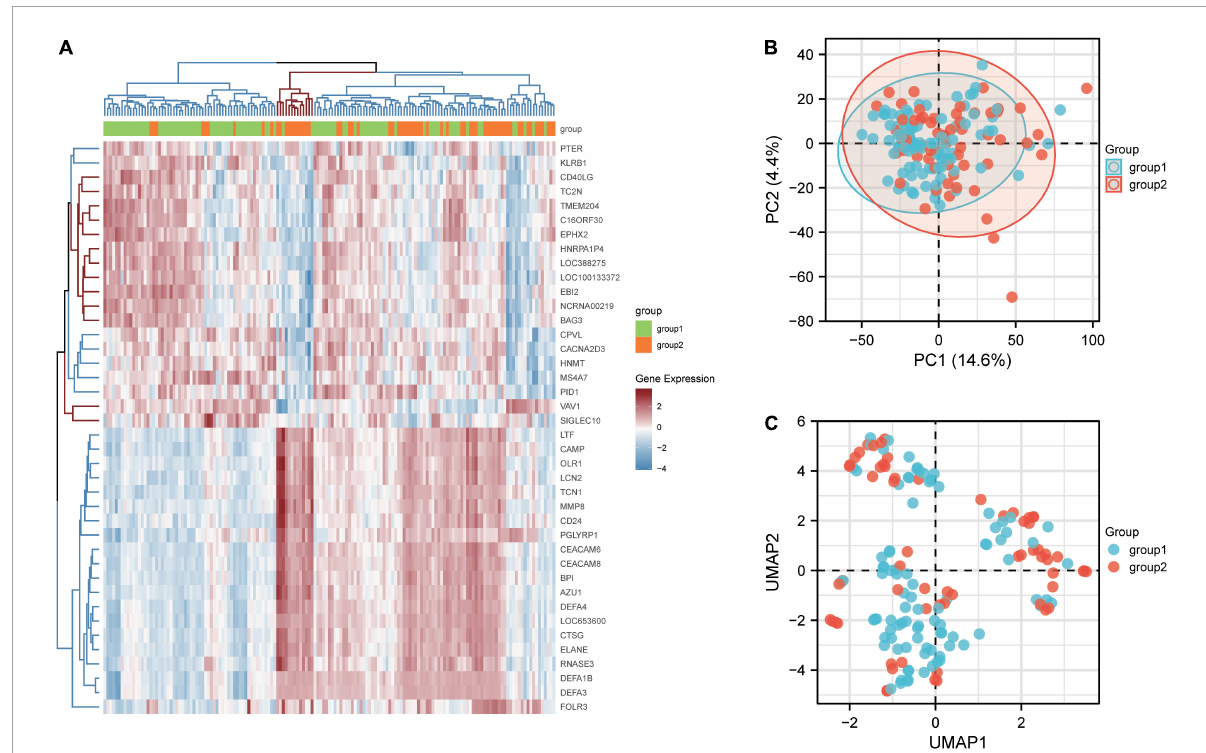
FIGURE2 Identification of DEGs between patients with and without renal involvement. (A) Heatmap of GSE65391, (B) principal component analysis (PCA) plot generated from DEGs in GSE49454, and (C) uniform Manifold Approximation and Projection (UMAP) showing distinct clusters of DEGs in GSE49454. Group1 stands for the patients without active renal involvement and group2 stands for patients with active renal involvement. Data points in red represent upregulated genes, and those in blue represent downregulated